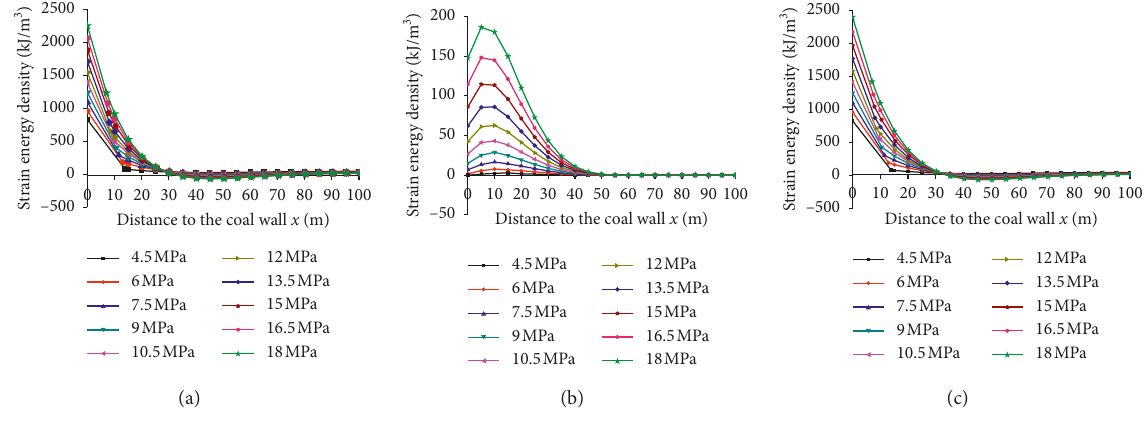
Figure 11: Strain energy density variation before and after the initial roof breakage event. (a) Coal mass. (b) Roof rock mass. (c) Overall working face.